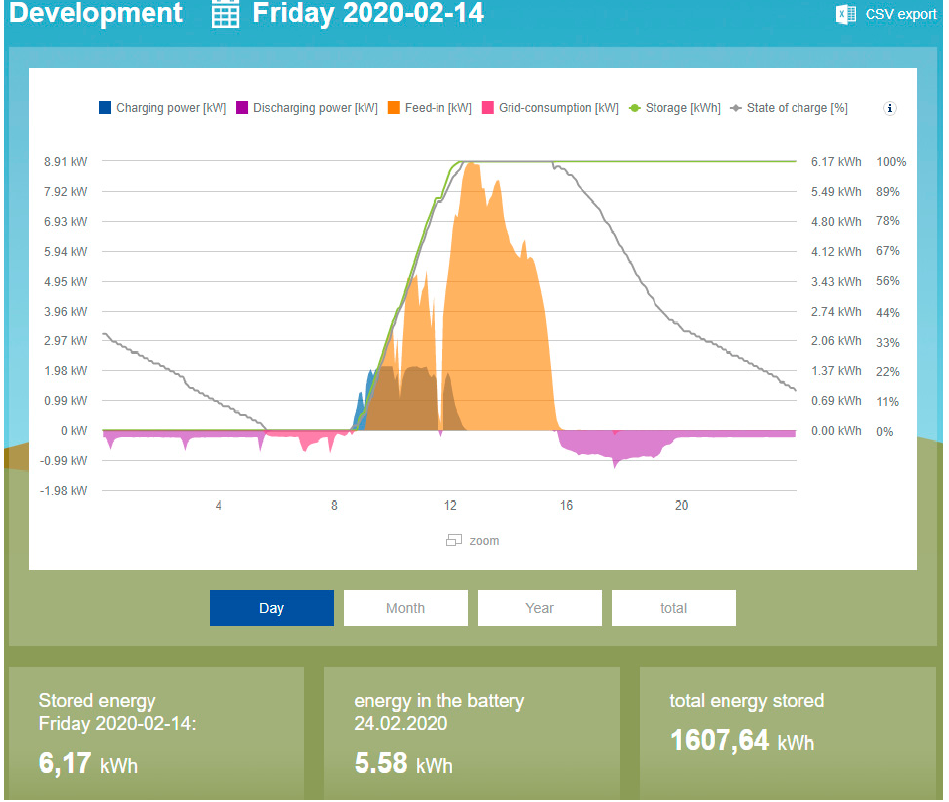
Figure 15. A screenshot of the real-time monitoring of the BESS.